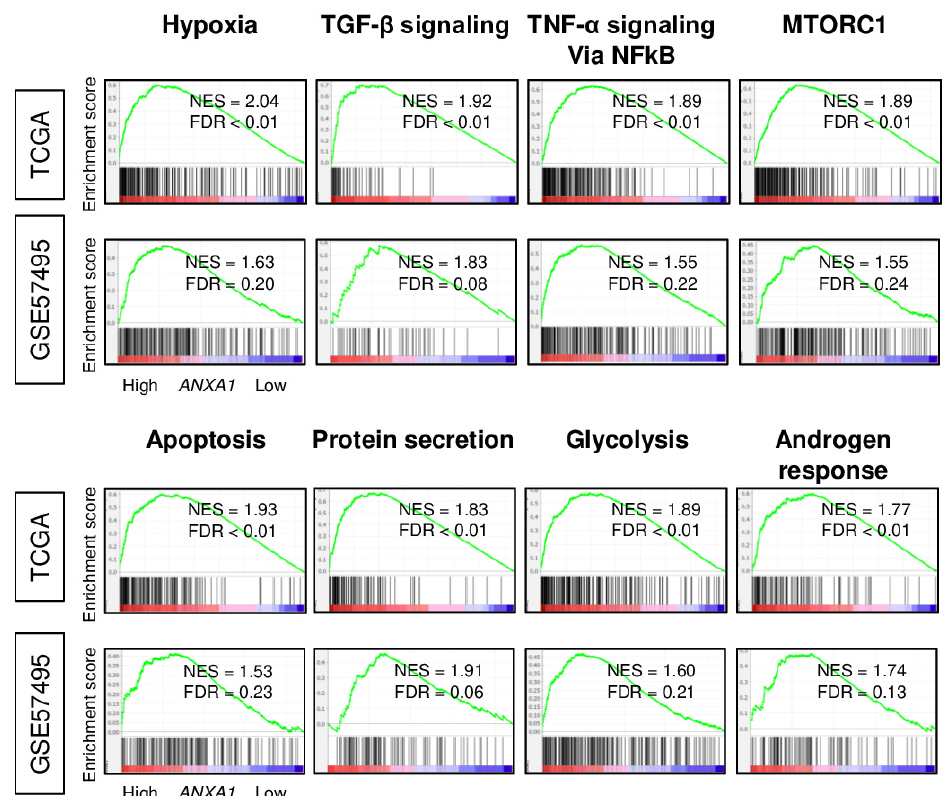
Figure 2. Gene set enrichment analysis of pancreatic cancer with high annexin A1 ( ANXA1 ) expres- sion in the TCGA and GSE57495 cohorts. Enrichment plots of hypoxia, transforming growth factor (TGF)- β signaling, tumor necrosis factor (TNF)- α signaling, MTORC1, apoptosis, protein secretion, glycolysis, and the androgen response of hallmark gene sets with NES and FDR. Median cut-off within each cohort was used to divide into ANXA1 low and ANXA1 high groups ( n = 88, respectively, in the TCGA and n = 31 and 32, respectively, in the GSE57495 cohort). NES, normalized enrichment score and FDR, false discovery rate.